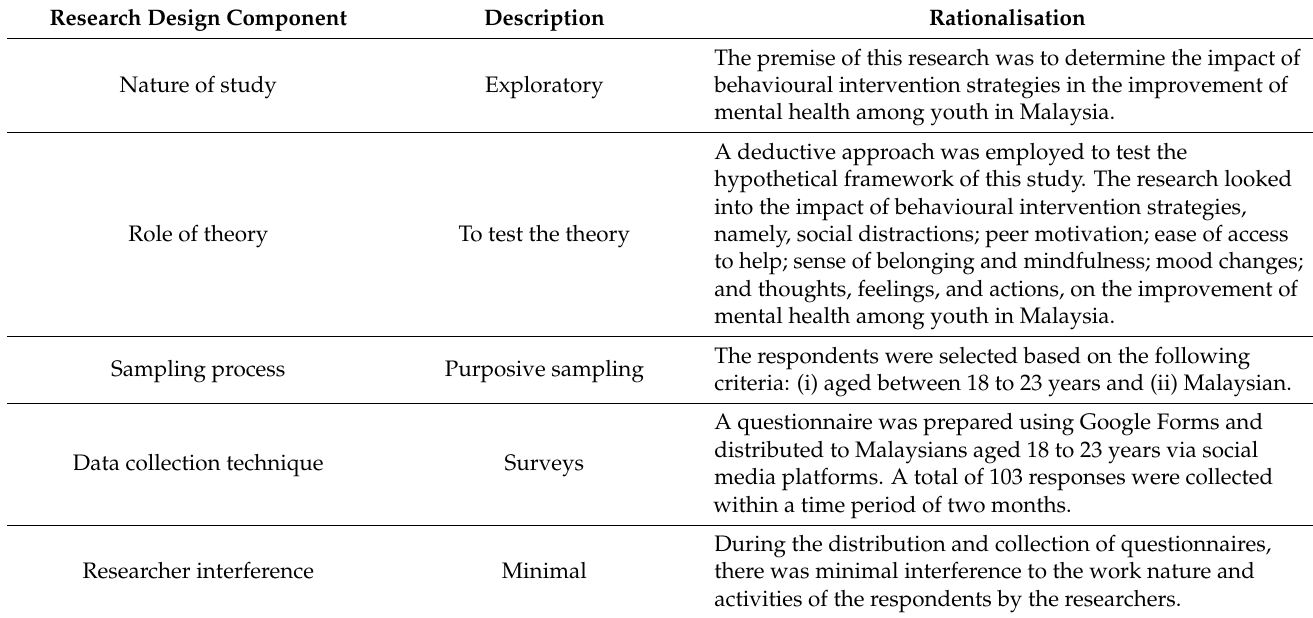
Table 1. Research design